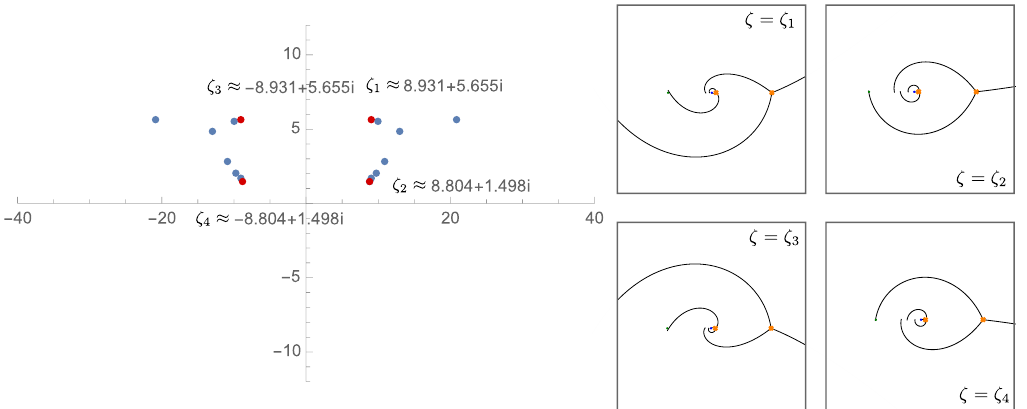
Figure 17 . Left: singularities in the Padé-Borel transform of the Y (2) in (3.7) for the operator (C.5). We take u = 1 , z = e x = − e and use N = 40 terms in the series. There are infinitely many poles of ˆ Y (2) , corresponding to the central charges of solitons on the surface defect parameterized by z . Only finitely many of them are visible in our approximation. (Again, for Y (1) the singularities would be at the opposite points ζ = − ζ .) Right: cutoff Stokes graphs at ζ = ζ , as in i 1 , ζ 2 , ζ 3 , ζ 4